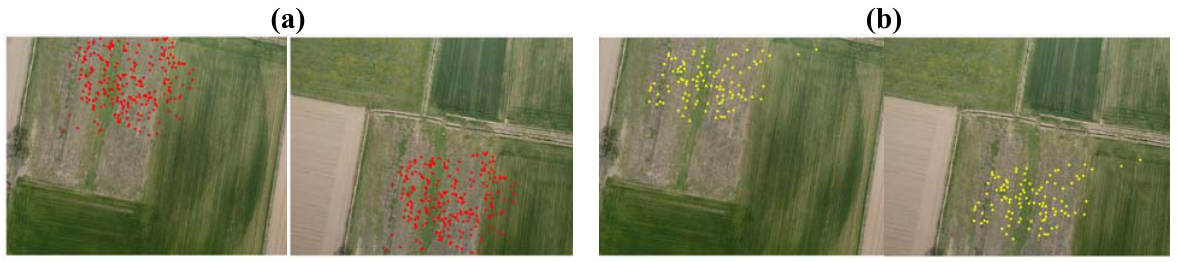
Figure 5. (a) The Villareggia test 1. The image correspondences automatically matched by SIFT (256 points, Th_key = 0.0005, L = 10). (b) The homologous points detected by ForLSM (100 points, NCC = 0.8, L = 10).